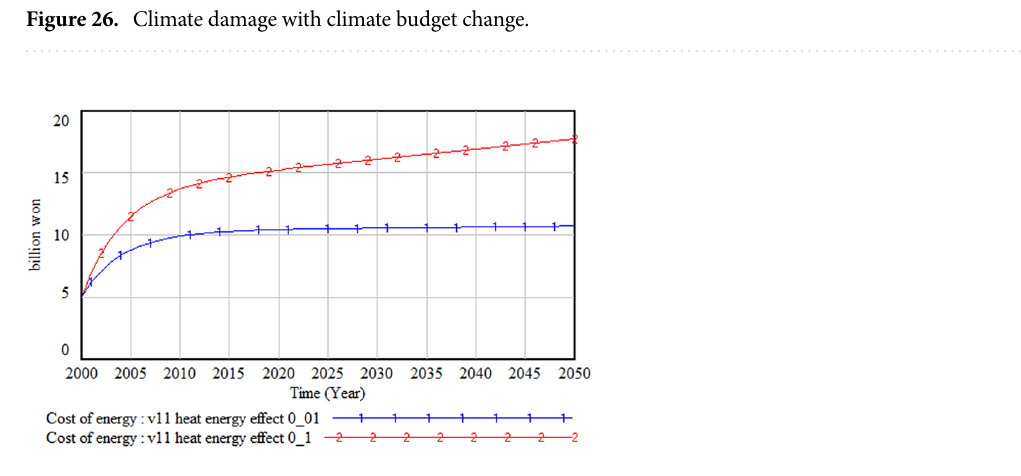
Figure 27. Impact of heat waves on energy